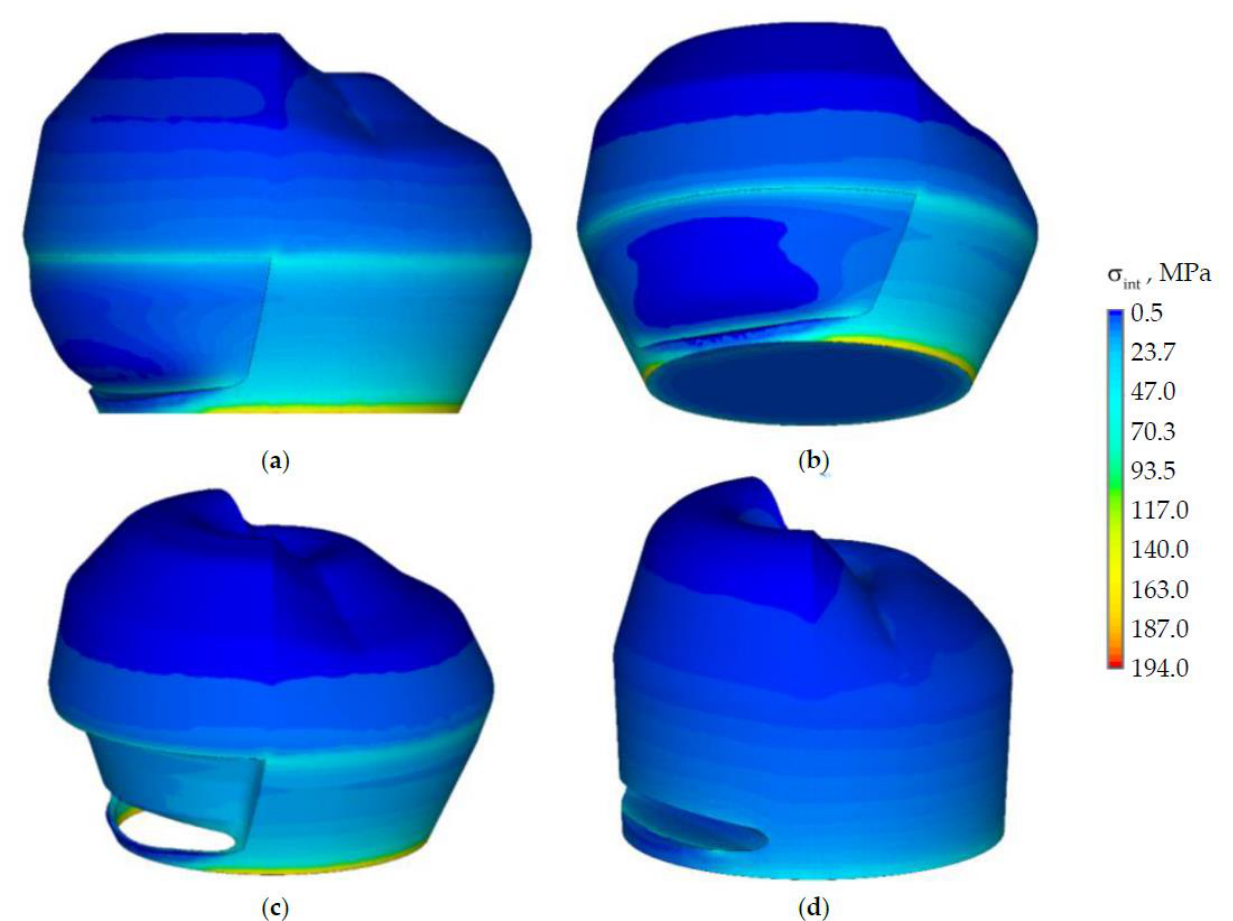
Figure 6. Stress intensity of the biomechanical assembly: ( a , b ) are tooth-inlay system; ( c ) is enamel; ( d ) is dentine.